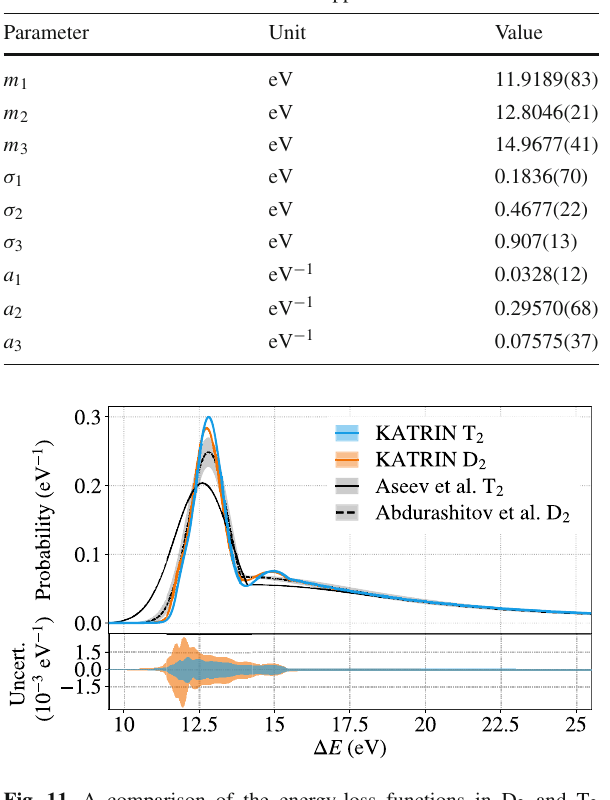
Fig. 11 A comparison of the energy-loss functions in D 2 and T 2 from this work and previous measurements of Aseev et al. [12] and Abdurashitov et al. [13]. The y-axis indicates the probability density normalized in Δ E ∈ [0 , E max ] for energy losses Δ E due to inelas- tic scattering. The Gaussian 1 σ uncertainty bands are indicated by the shaded areas 3 . Since the uncertainty of the KATRIN T 2 and D 2 results are too small to be visible in the top plot, the uncertainties are addition- ally shown in absolute values in the bottom